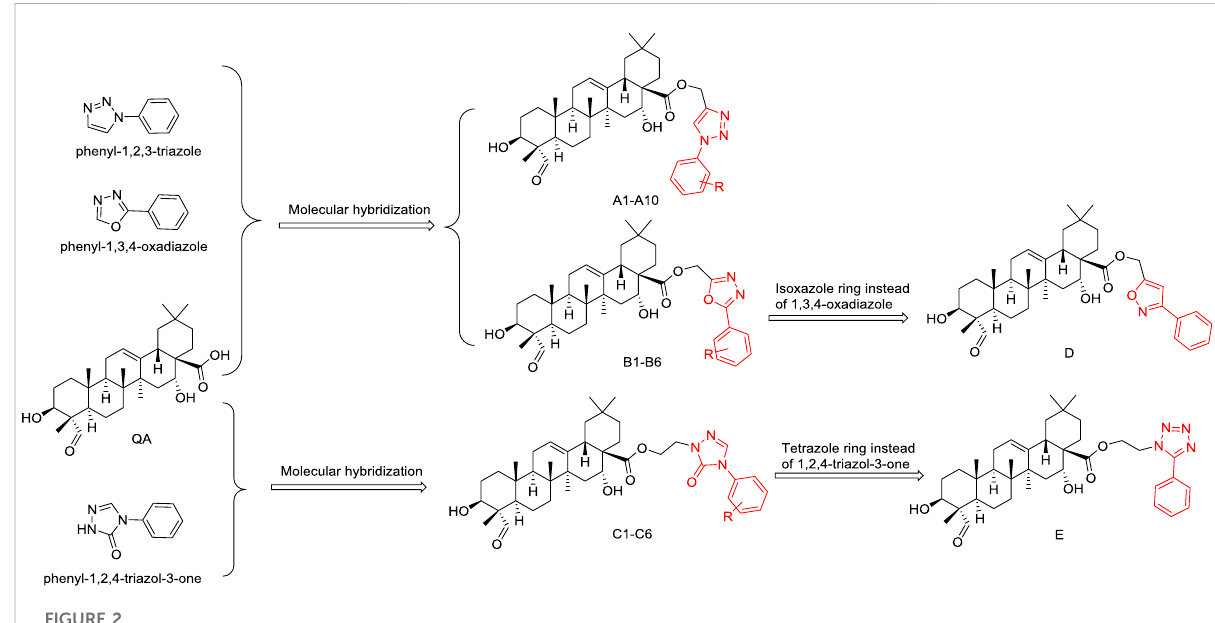
FIGURE 2 Designing quillaic-acid derivatives containing a nitrogen-containing heterocycle to achieve potential anti-proliferative activity.